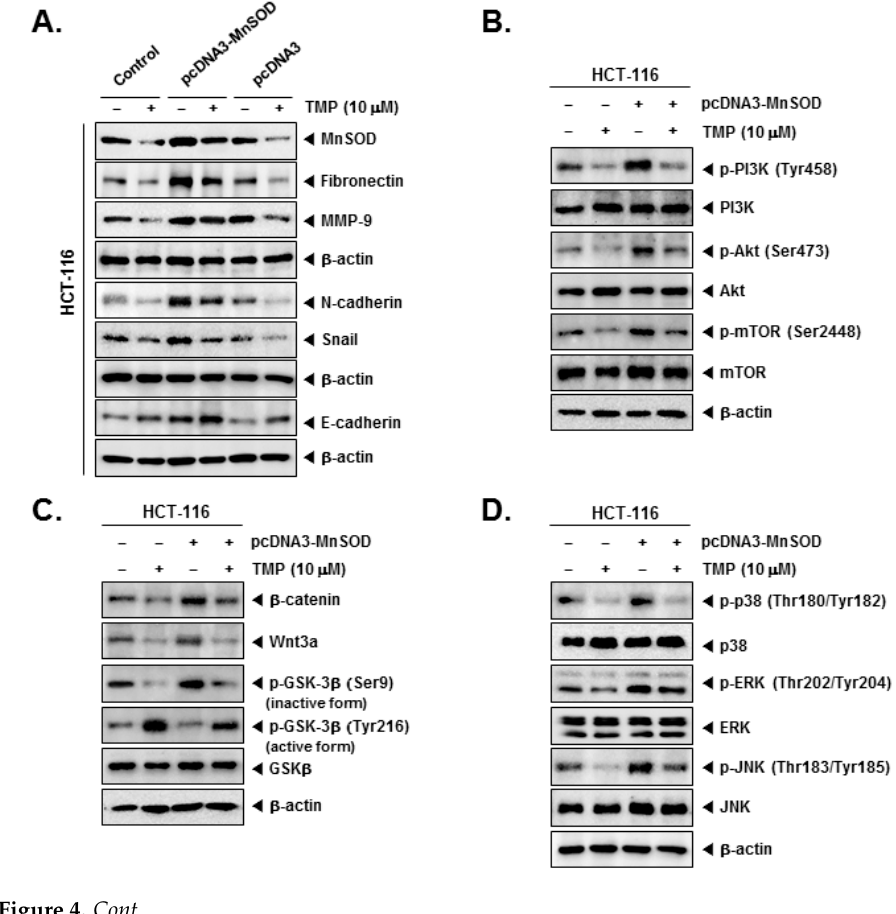
Figure 4. Effects of TMP on MnSOD overexpressed invasion, and migration in HCT-116 cells. HCT- 116 cells (5 × 10 4 cells/well) were transfected with pcDNA3-MnSOD for 24 h. ( A ) Then, cells were treated with TMP (10 μ M) for 24 h. Indicated EMT markers were evaluated by Western blot analysis. ( B ) The cells were treated with TMP (10 μ M) for 6 h, then PI3K/Akt/mTOR activation was analyzed by Western blot analysis. ( C , D ) TMP (10 μ M, 6 h) treated cells were evaluated Wnt/ β -catenin and MAPK signals by Western blot analysis. ( E ) Invasion activity of MnSOD overexpressed cells was evaluated by Boyden chamber assay. The cells were incubated for 5 h and stained in blue for observation. ( F ) MnSOD-overexpressed HCT-116 cells were treated with TMP (10 μ M), then cell proliferation was evaluated by RTCA. All the experiments were repeated at least thrice independently. ### p < 0.001 vs. non-treated (NT) cells, ## p < 0.01 vs. non-treated (NT) cells, and *** p < 0.001 vs. pcDNA3-MnSOD transfected cells. ** p < 0.01 vs. pcDNA3-MnSOD transfected cells.